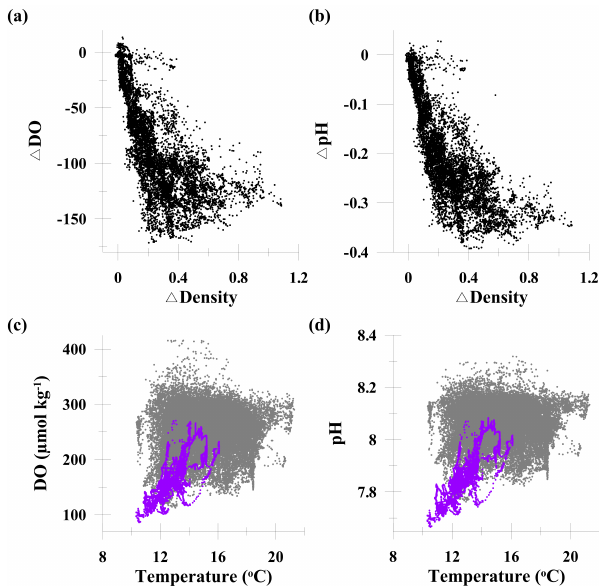
Fig. 6. Scatter plots of (a) density difference ( 1 Density) and dis- solved oxygen difference ( 1 DO) between 7 and 17m at mooring A, and (b) 1 Density and pH difference ( 1 pH) between 7 and 17m at mooring A. Includes all data from Fig. 5. Scatter plots of (c) tem- perature and DO, and (d) temperature and pH at 7m (grey hatches) and 17m (purple hatches) below the surface from all SeapHOx de- ployments from 10 July 2010–19 October